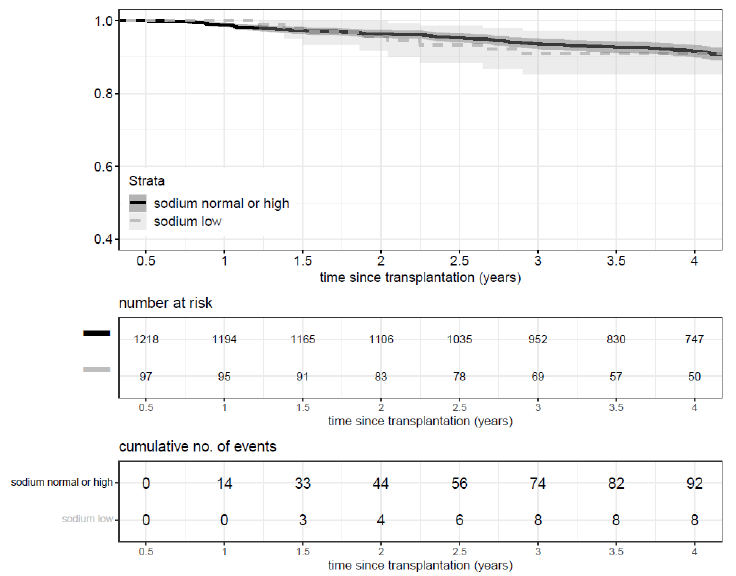
Figure 4. Kaplan Meier curve of outcome of death or graft loss by sodium level.